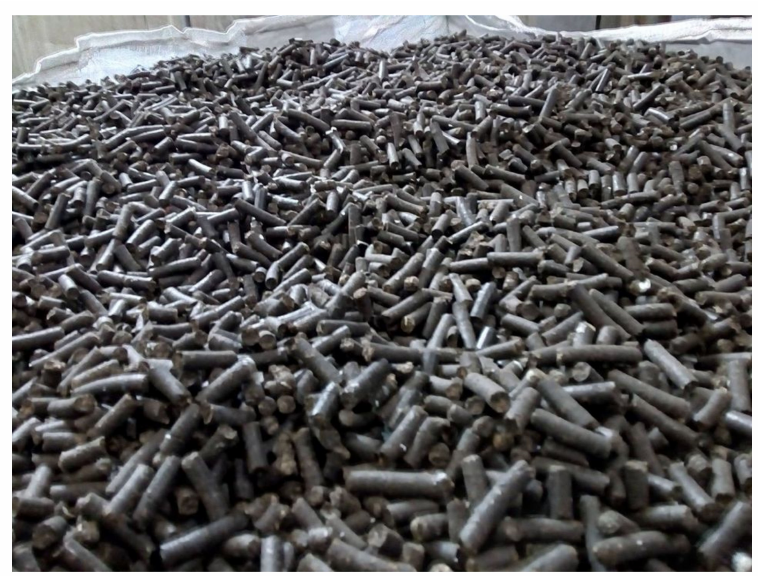
Figure 19. Bio-pellet from Sobawiny biogas plant (photo B.